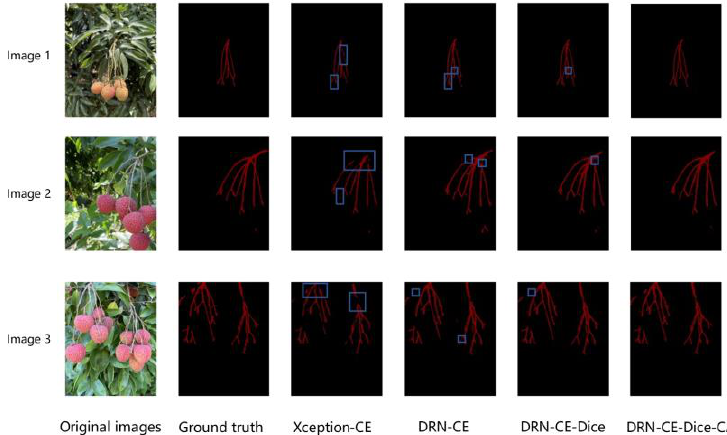
Figure 7. A comparison of the network prediction effects.